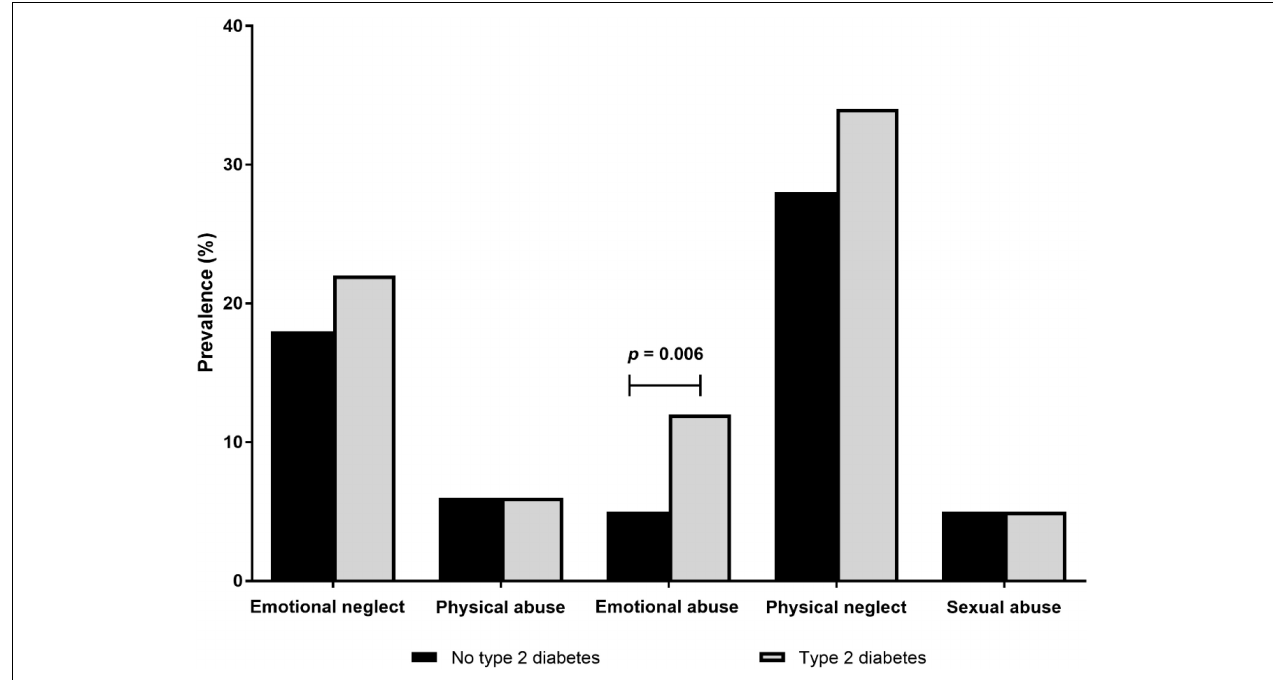
FIGURE 1 | Cumulative incidence of type 2 diabetes in participants according to childhood maltreatment categories ( N = 2,973).